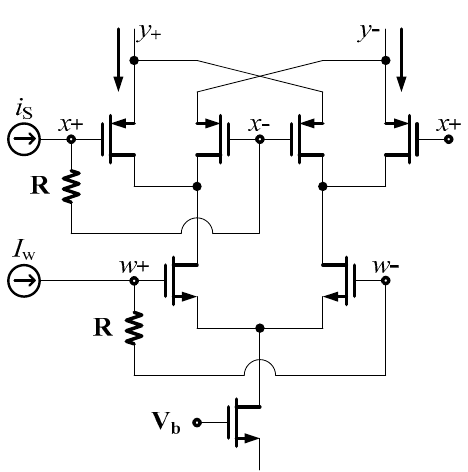
Figure 2. An analog multiplier employed to implement Cellular Neural Networks [17,18].